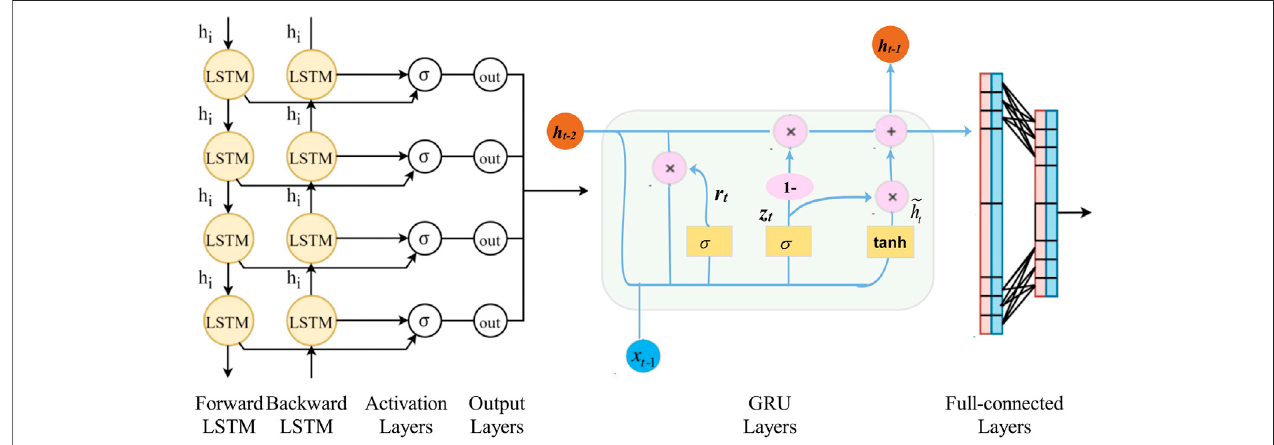
FIGURE 1 | Flowchart of the proposed bidirectional long short-term memory-gated recurrent unit (GBiLSTM) model.